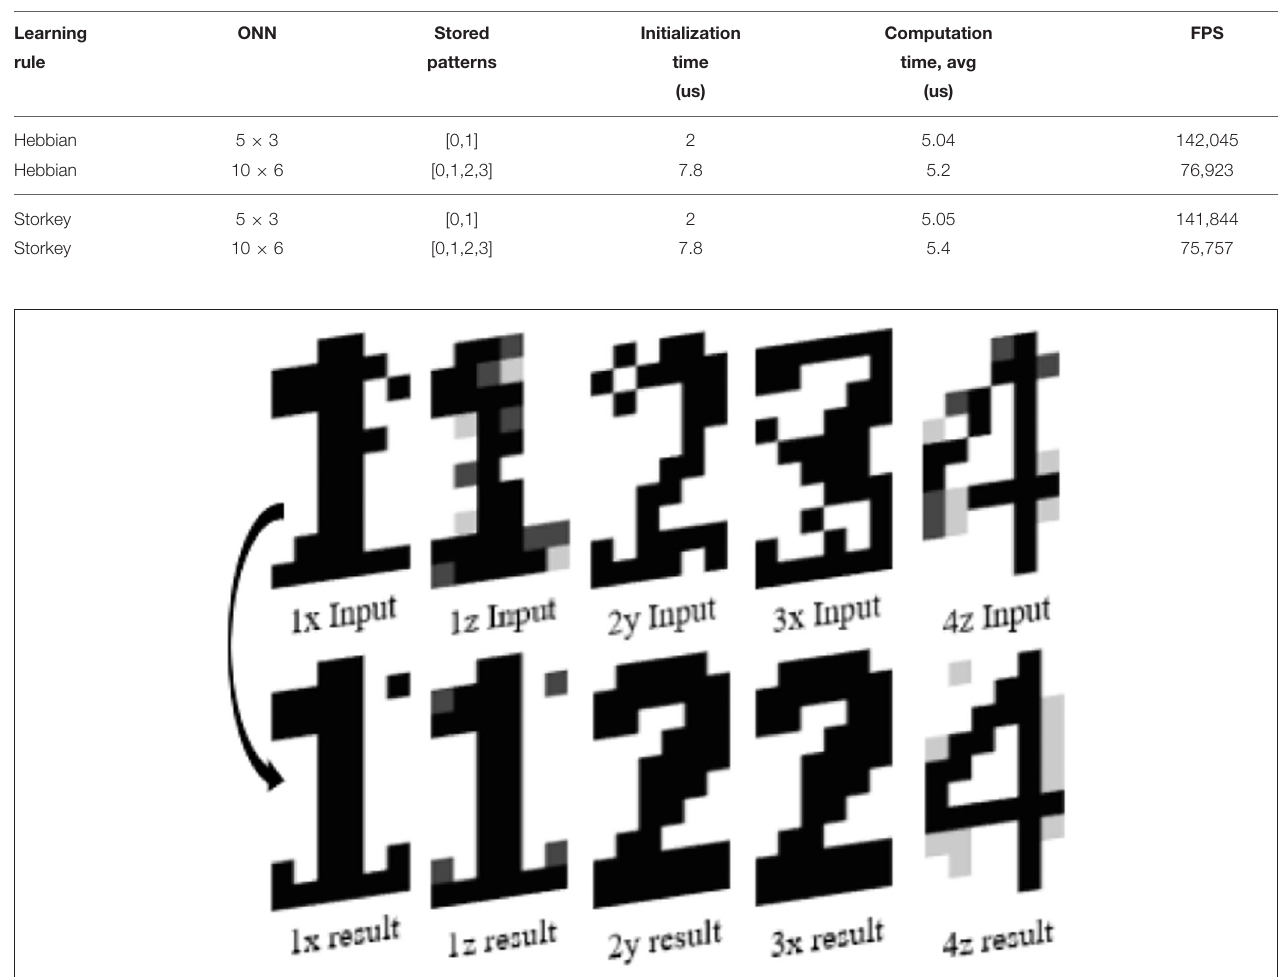
FIGURE 9 | Representation of error images for 10 × 6 ONN digit recognition application showing incorrect